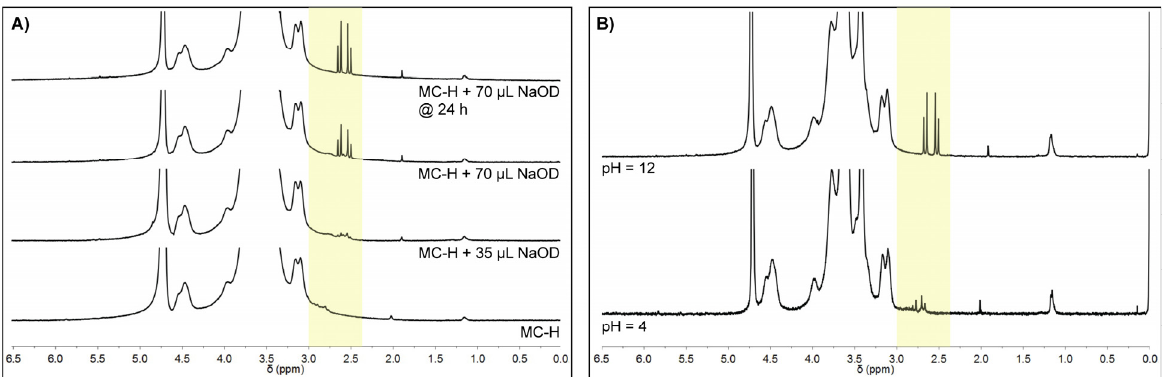
Figure 4. 1 H-NMR spectrum of ( A ) washed MC-H sample swelled in D 2 O and then hydrolyzed and ( B ) non-washed MC-H specimens swelled at different pH (4 vs. 12). All the spectra were acquired at 30 °C. The yellow area highlights the -CH 2 - peaks of CA.